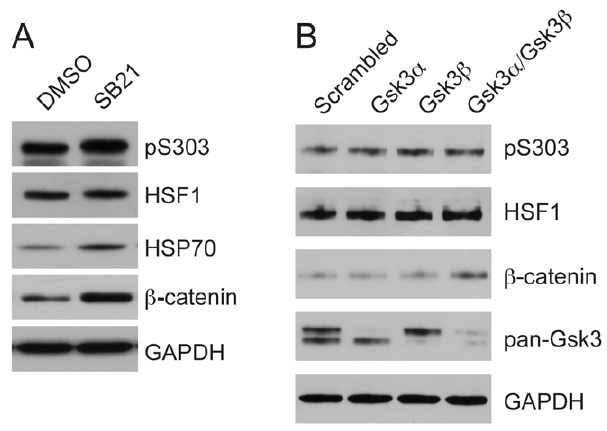
Figure 5. GSK3 represses HSF1 activity in HeLa cells indepen- dent of S303 phosphorylation. ( A ) HeLa cells were treated with DMSO solvent or the GSK3 inhibitor SB-216763 (25 m M) for 15 h. Total protein was analyzed for pS303, HSF1, and b -catenin by immunoblot- ting. GAPDH serves as a loading control. ( B ) HeLa cells were treated with siRNA specific for GSK3 a and GSK3 b either individually or together or a scrambled siRNA for 72 h. Total protein was analyzed for pS303, total HSF1, b -catenin, GSK3 a / b and GAPDH by